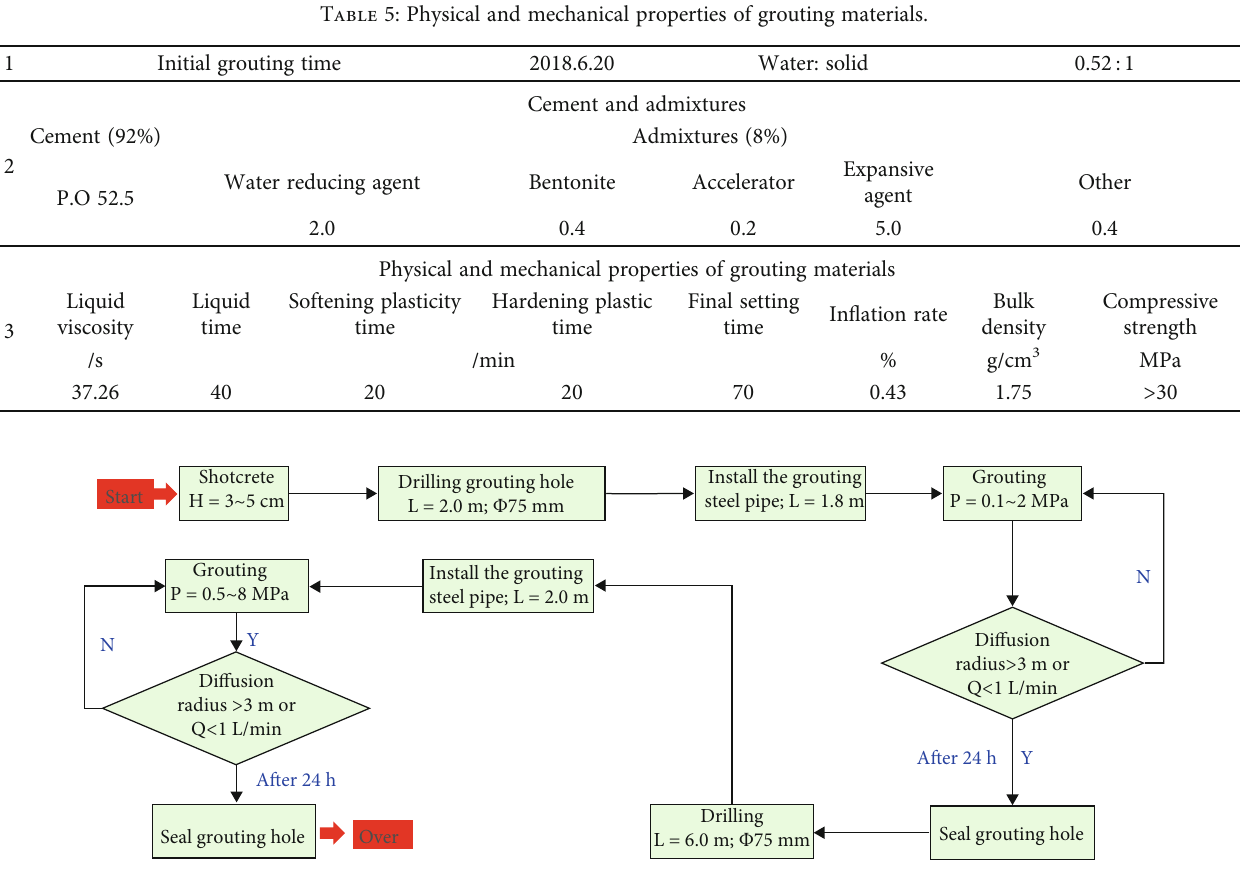
Figure 8: Grouting process and control